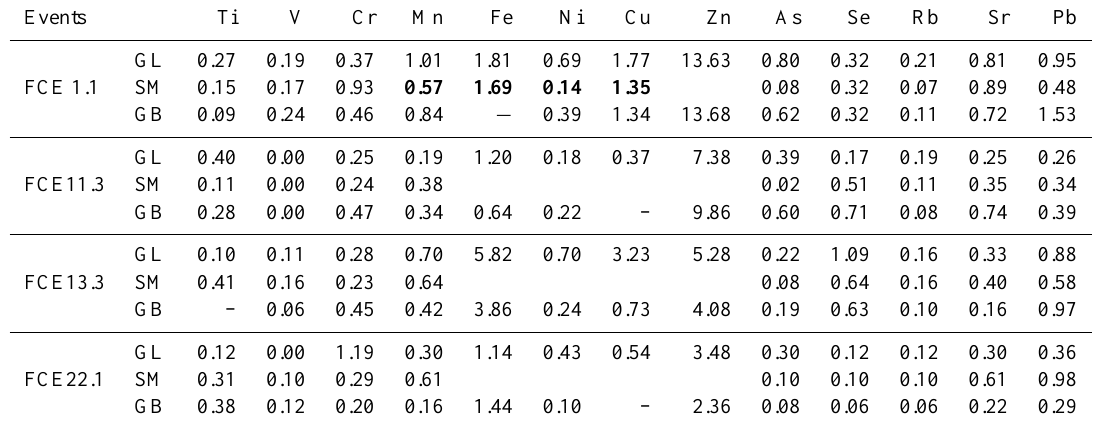
Table 4. PM 10 -soluble aerosol trace metal content at the upwind station Goldlauter (GL), downwind station Gehlberg (GB), and soluble trace metals in cloud water at Mt. Schmücke (SM) during four FCEs.